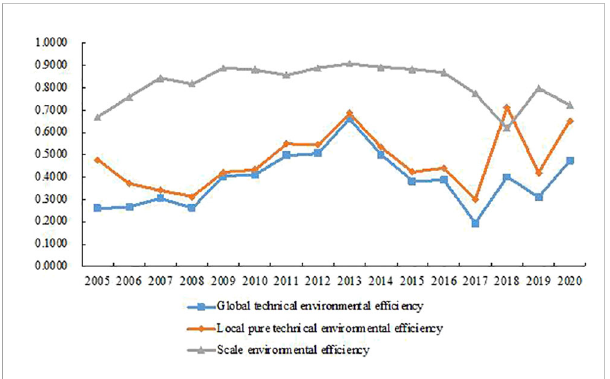
FIGURE 1 The annual average environmental ef fi ciency of the eight